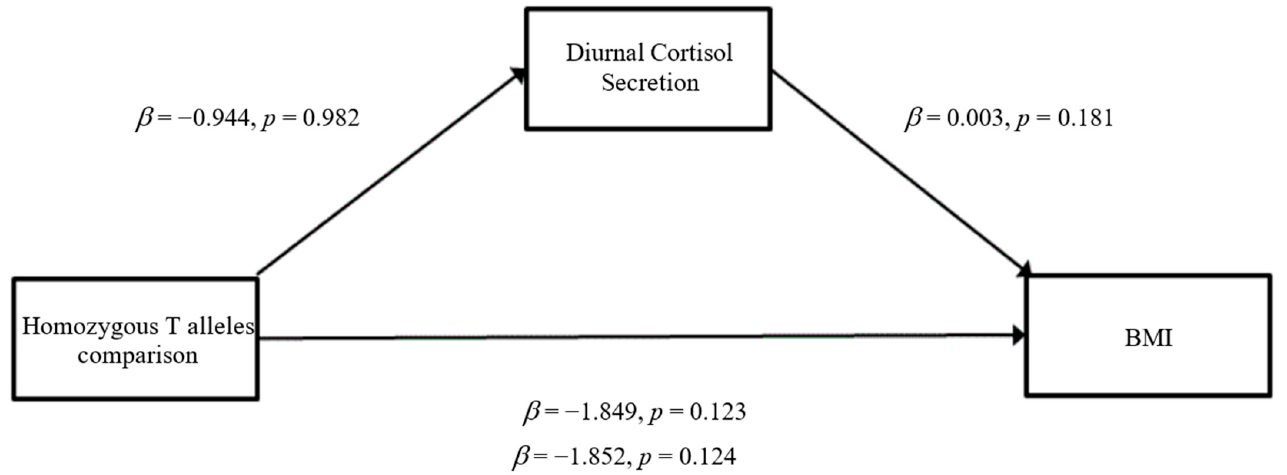
Figure 4. Mediation model for Homozygous T alleles comparison with BMI through the pathway of diurnal cortisol secretion (Model 4).